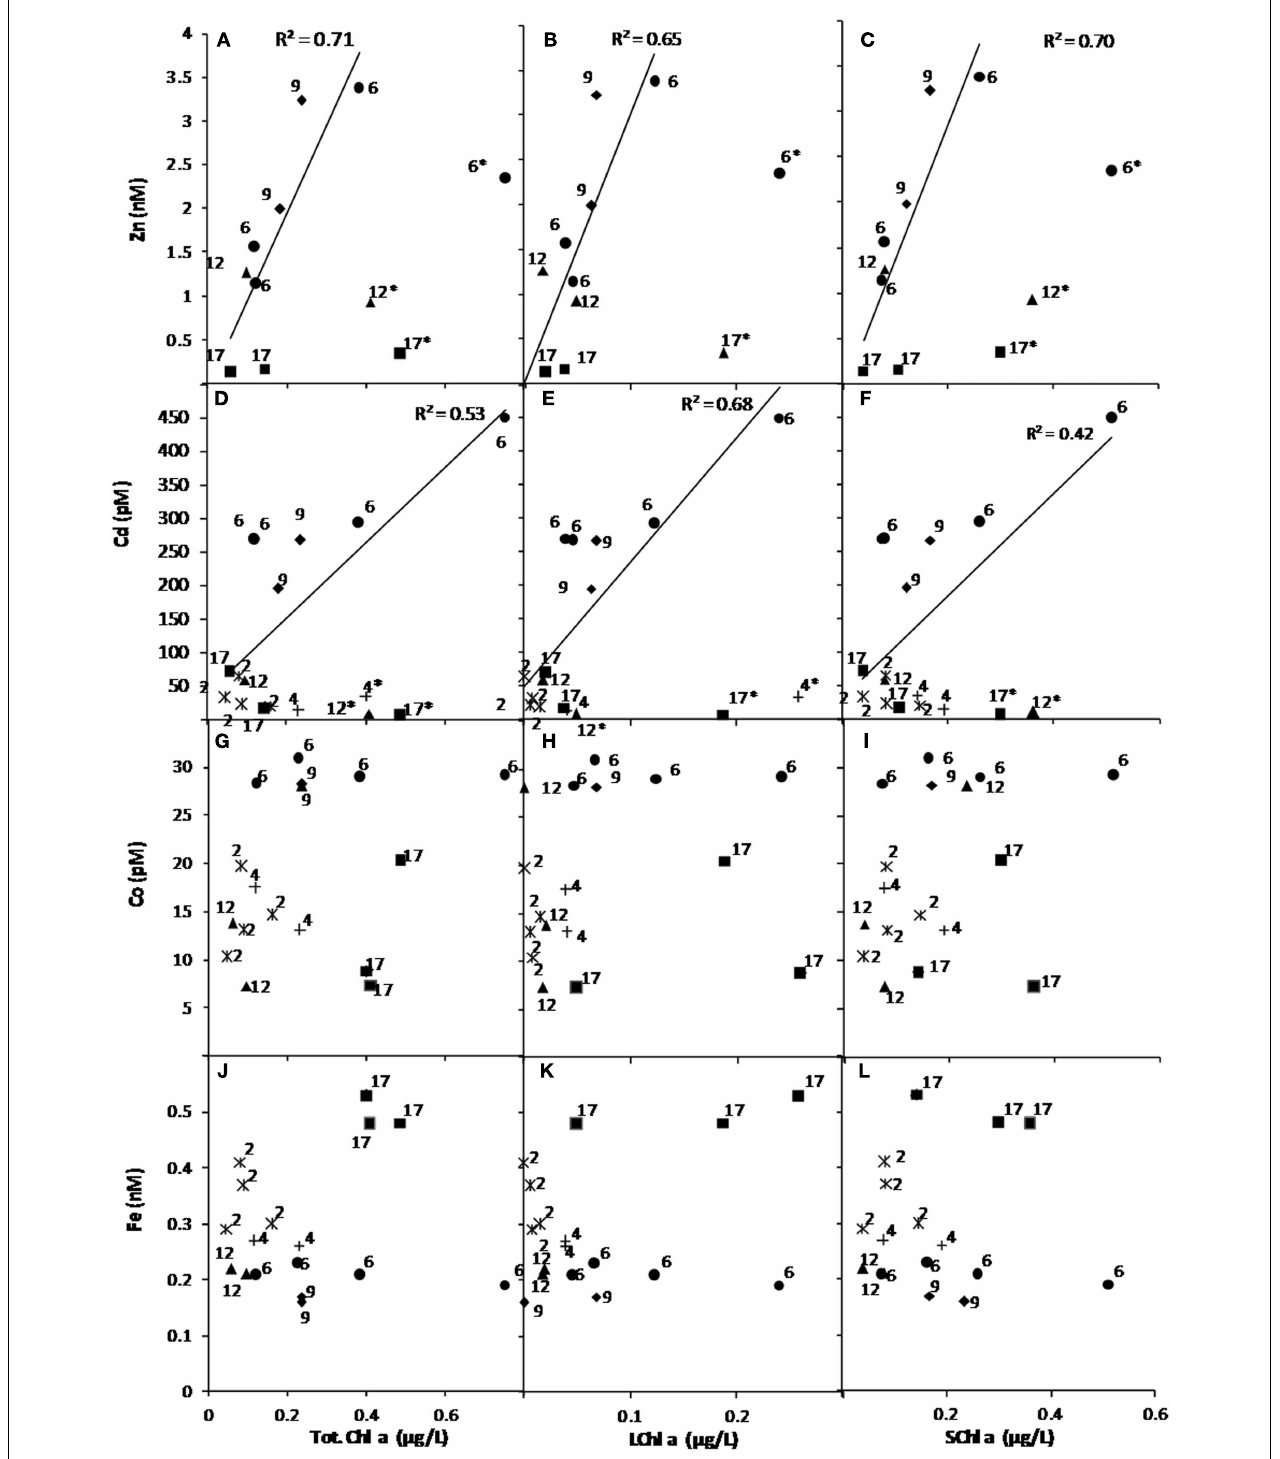
given when significant relationships were found (Zn and Cd only). Each station has been represented using a different symbol and the station labeled with “ * ” correspond to depth with a maximum of Chl a and were removed to obtain a significant correlation for Cd and Zn. Fe data are from Lannuzel et al.